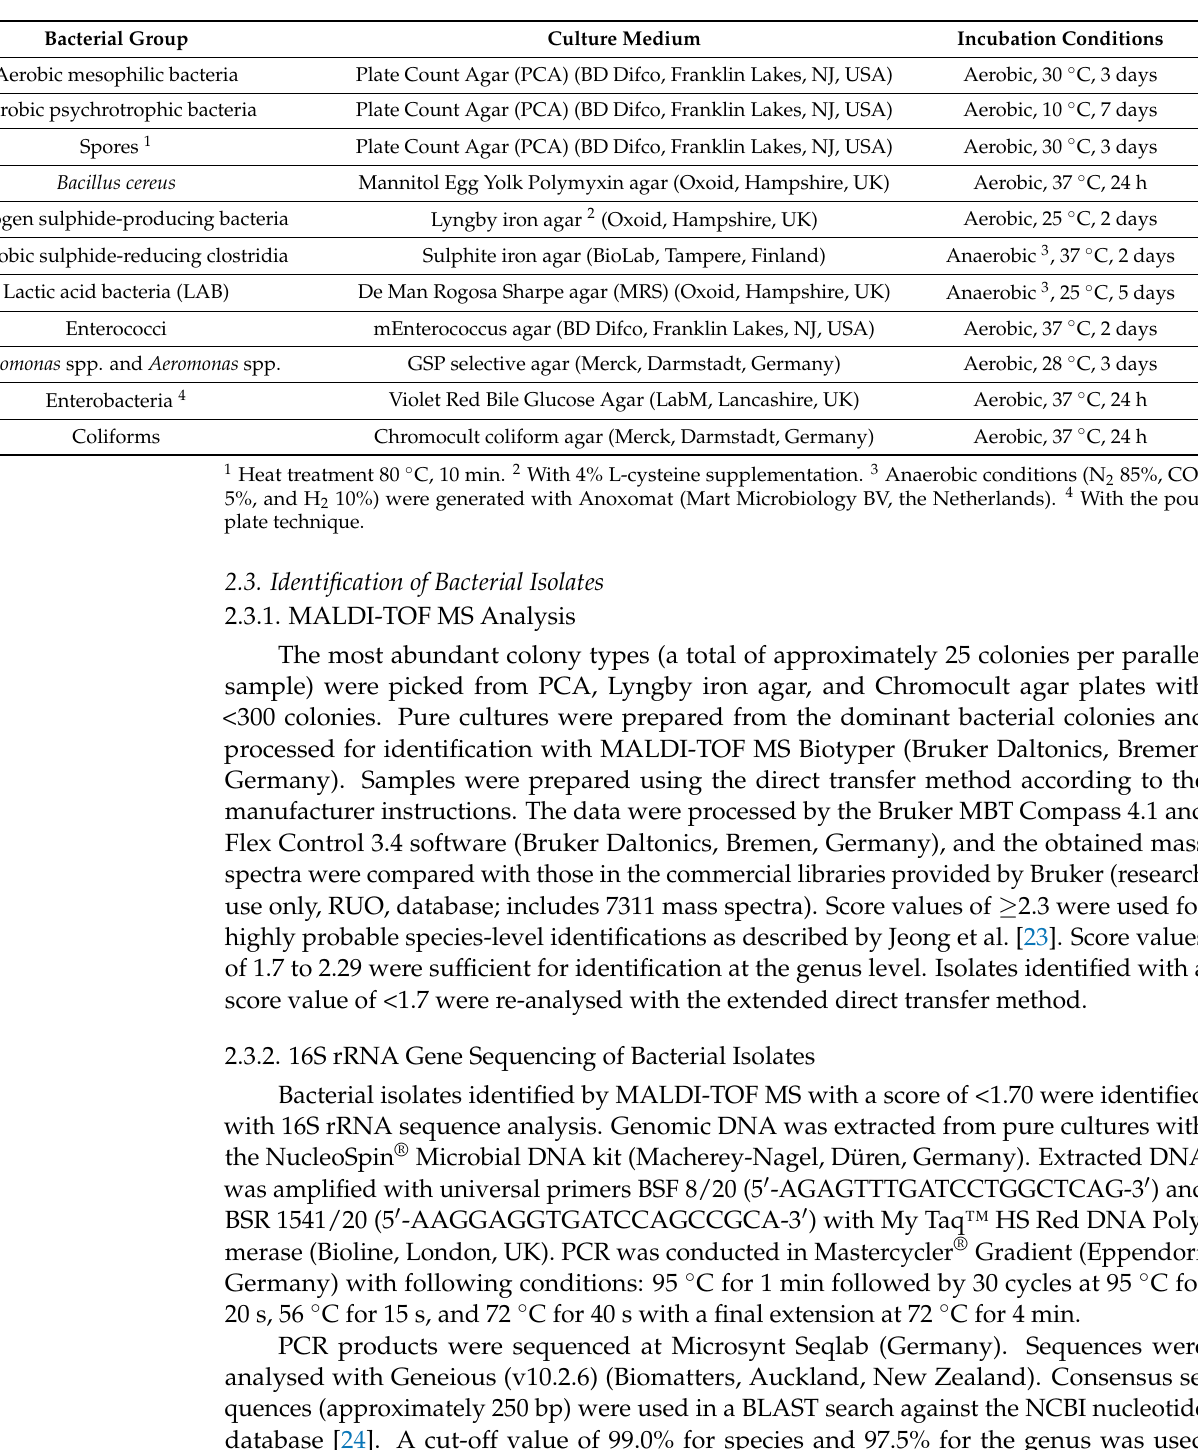
Table 1. Media used for direct enumeration of